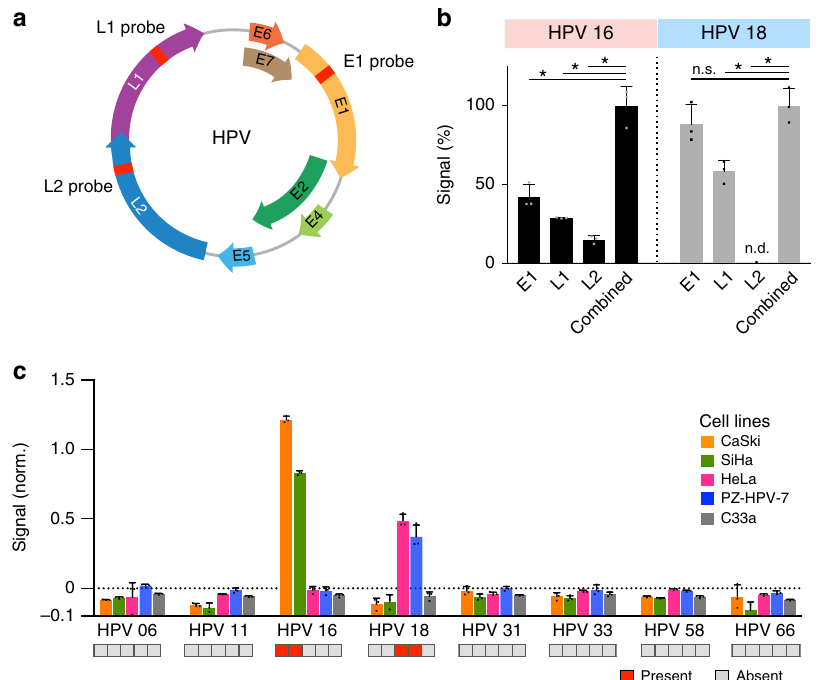
Fig. 4 Multiplexed enVision for multi-loci coverage. a New probe loci in HPV genome map. The HPV genome is made up of seven early expressed (E) genes and two capsid protein (L) genes. New nanostructure recognition probes were designed for each HPV subtype to identify the E1 , L1 , and L2 loci, respectively. b Multiplexed enVision assays for high-coverage, multi-loci detection. Genomic DNA obtained from CaSki cells (left, HPV 16-positive) and HeLa cells (right, HPV 18-positive) were incubated directly with individual recognition probes ( E1 , L1 , and L2 , respectively) or a pool of three probes (combined) to determine the cellular HPV infection status. The combined probes showed signi fi cantly higher signals as compared to any of the individualized assays (* P < 0.0005, n.s. not signi fi cant, Student ’ s t test; n.d. not detected). All signals were normalized as a percentage to their respective combined signals. c HPV subtyping in cell lines. Genomic DNA from cell lines were pro fi led directly using the multiplexed enVision assays for different HPV subtypes. The measurements correlated well with the known HPV infections of the cell lines, as reported by previous literatures (red: present, gray: absent). All measurements were performed in triplicate, and the data are displayed as mean ± different combinations of DNA targets (Supplementary Fig. 10 ; Supplementary Table 5).